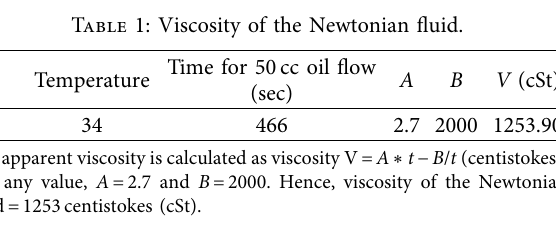
Table 2: Viscosity of the non-Newtonian fluid.